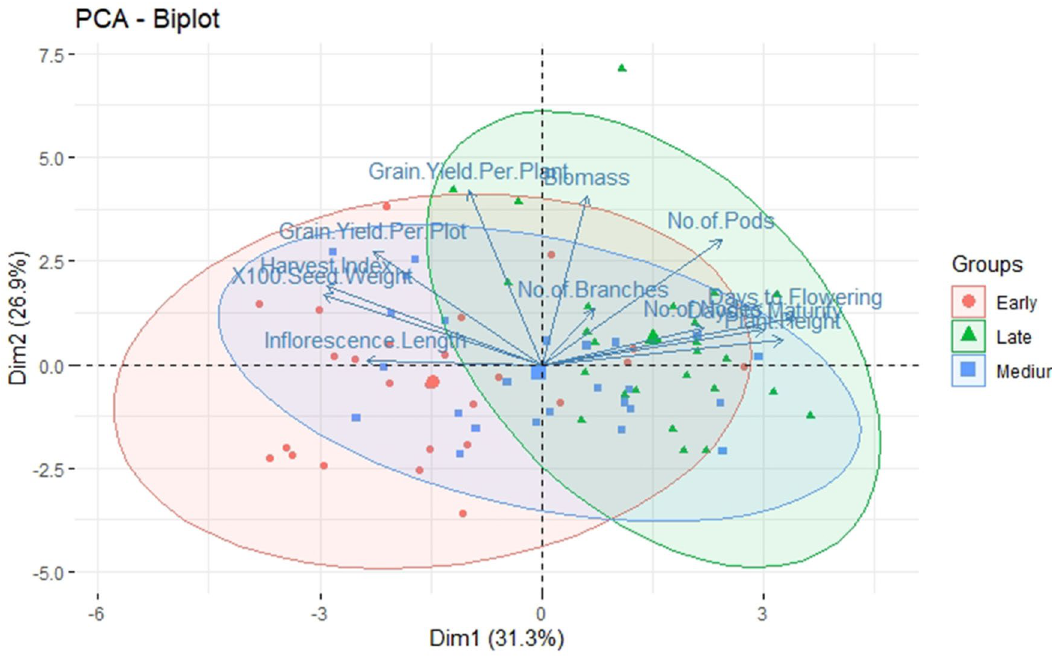
Figure 2. PCA for different quantitative traits in three different maturity groups (early, medium and late maturing